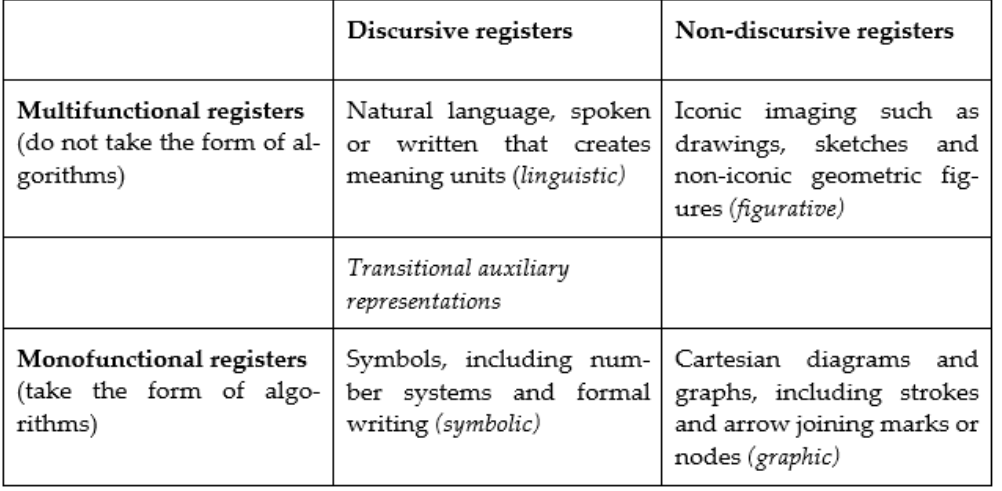
Figure 2. Duval’s four registers of semiotic representations.